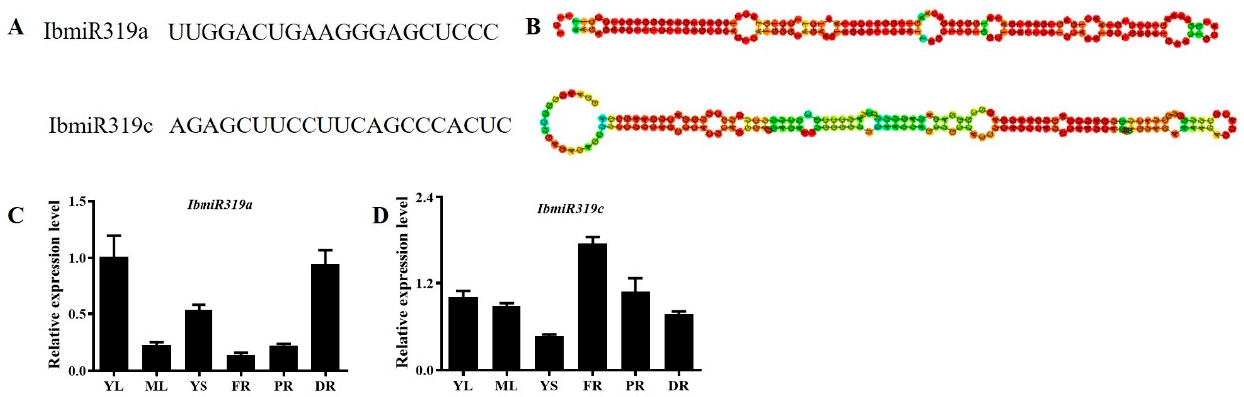
Figure 1. The microRNA319 family contains two members in sweet potato. ( A ): Sequence of